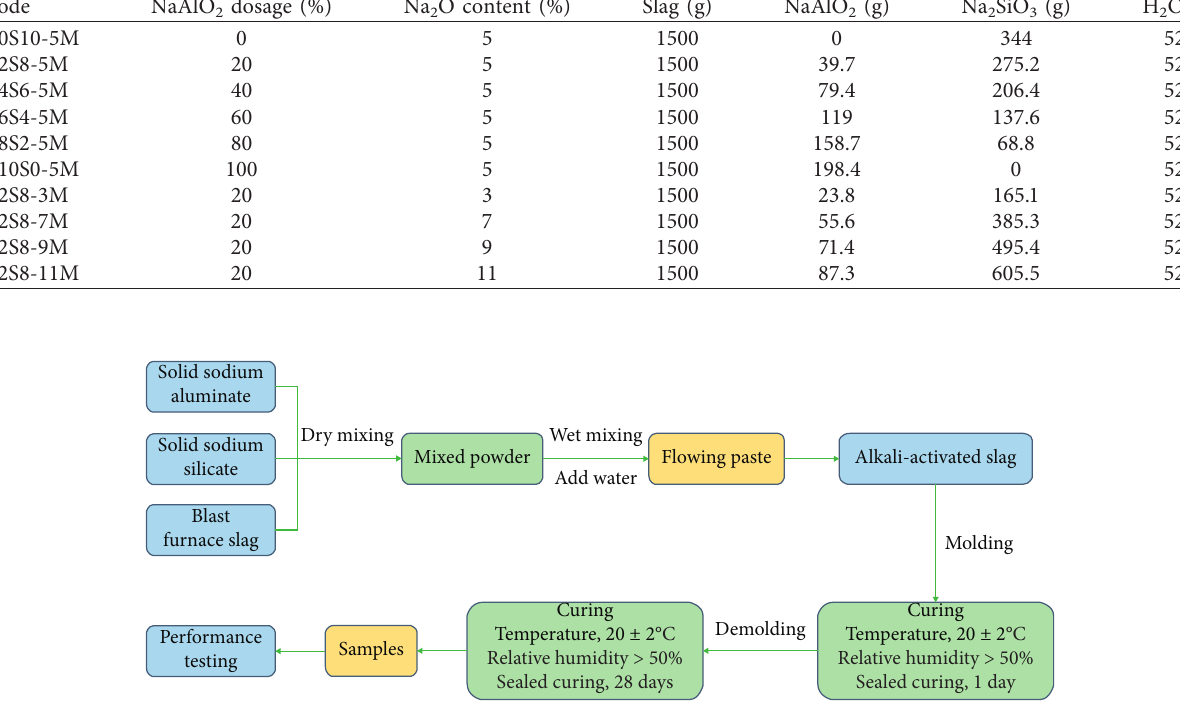
Figure 2: The AAS preparation